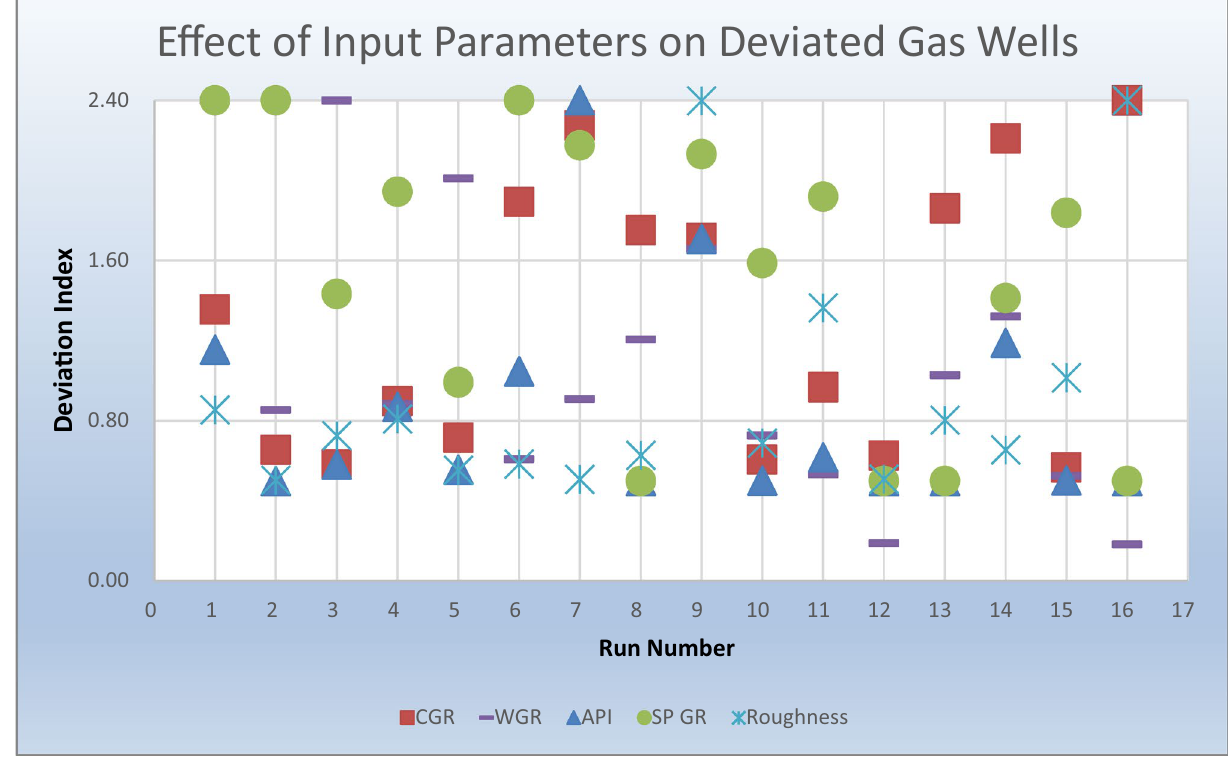
Fig. 15 Effect of different input parameters on deviated wells using deviation index